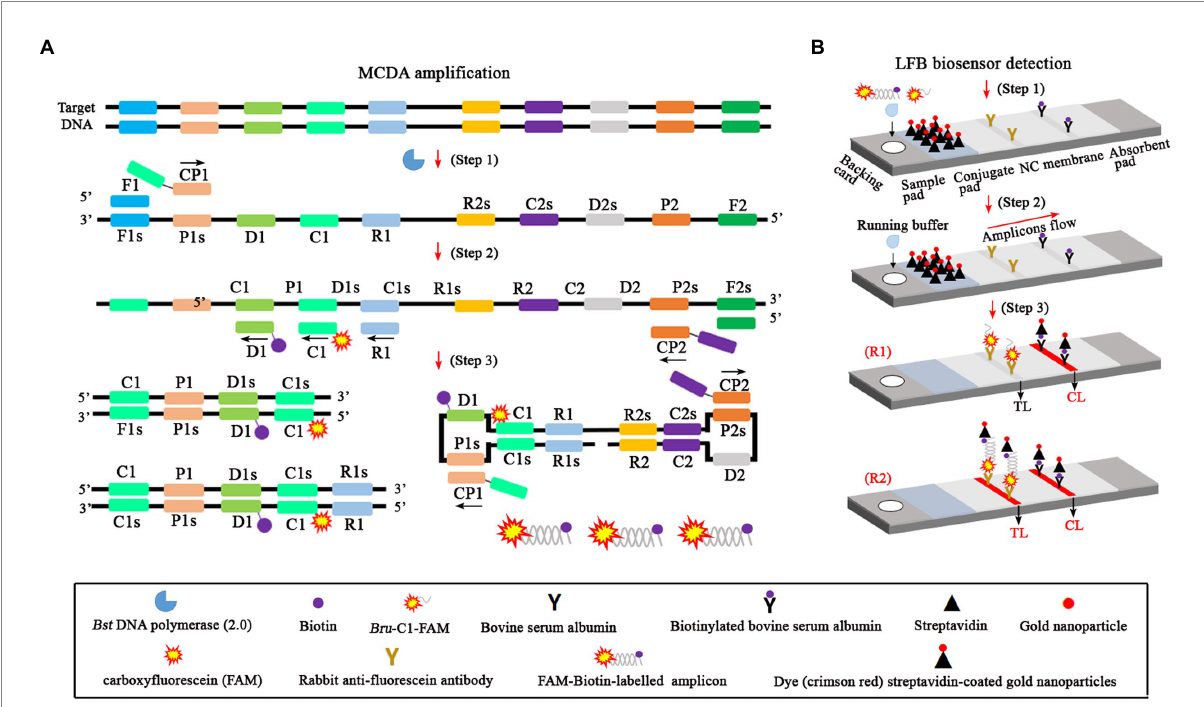
FIGURE 1 An overview of the detection principle of the Brucella abortus -MCDA-LFB assay. The whole process of the B. abortus -MCDA-LFB assay included MCDA amplification (A) and AuNPs-LFB biosensor detection (B) . In this report, the DNA templates were prepared from whole blood samples ( A , step 1 ), and the target regions on the template were amplified exponentially with primers driven by the Bst DNA polymerase ( A, steps 2 and 3 ). One aliquot of MCDA amplicons with the FAM and biotin labels (0.8–1.2 μ l) and two drops of running buffer (100–150 μ l) was added to the sample pad on the AuNPs-LFB biosensor ( B, step 1 ). Subsequently, the biotin was coupled with SA-AuNP particles in conjugated pads to form the FAM/target/biotin/ SA-AuNP complexes, which were captured by an anti-FITC antibody, resulting in a red TL line ( B, steps 2 and 3 ). MCDA, multiple cross displacement amplification; AuNPs-LFB, gold nanoparticles-based lateral flow biosensor; TL, test line; CL, control line; FAM,